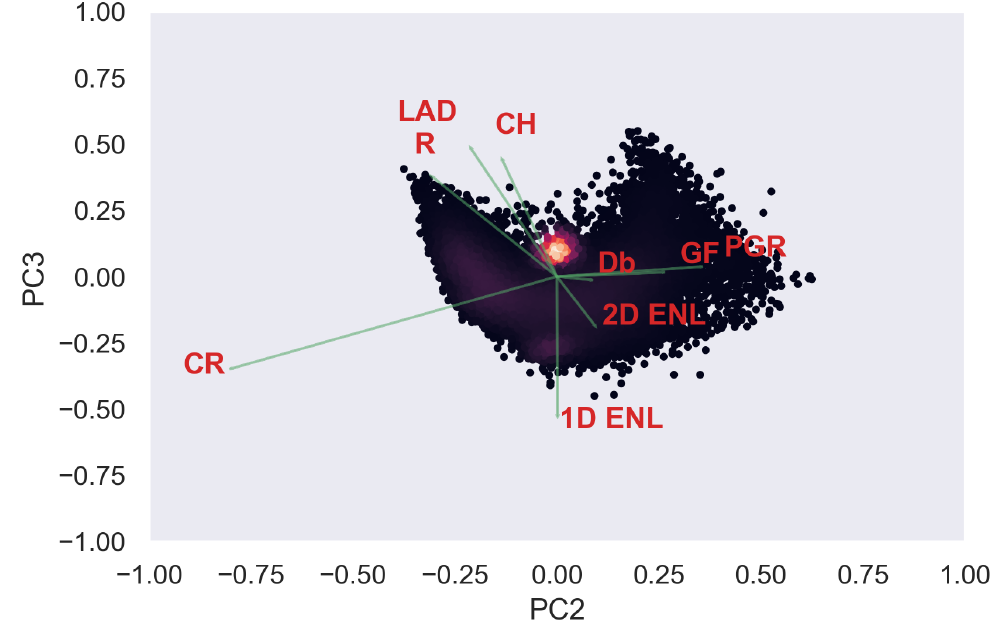
Figure A19. TLS PCA band 2 and 3 loadings at 0.5 m grid